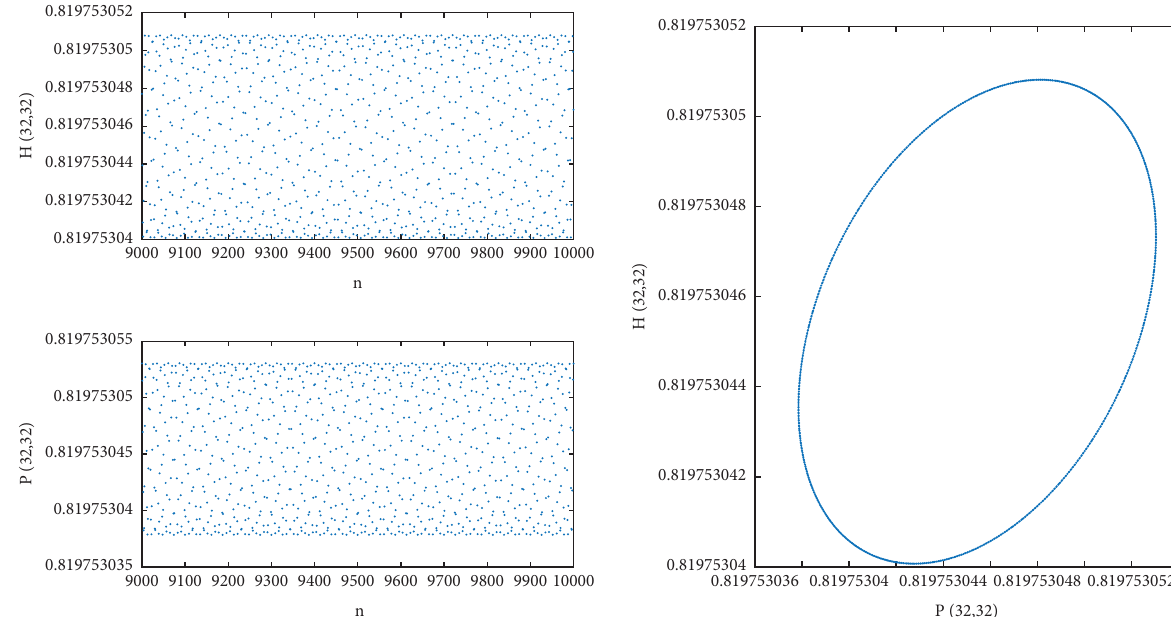
Figure 21: R � 2 , k � 1, c � 0 . 8, σ ∗ � 0 . 278655, σ � σ ∗ , ( d